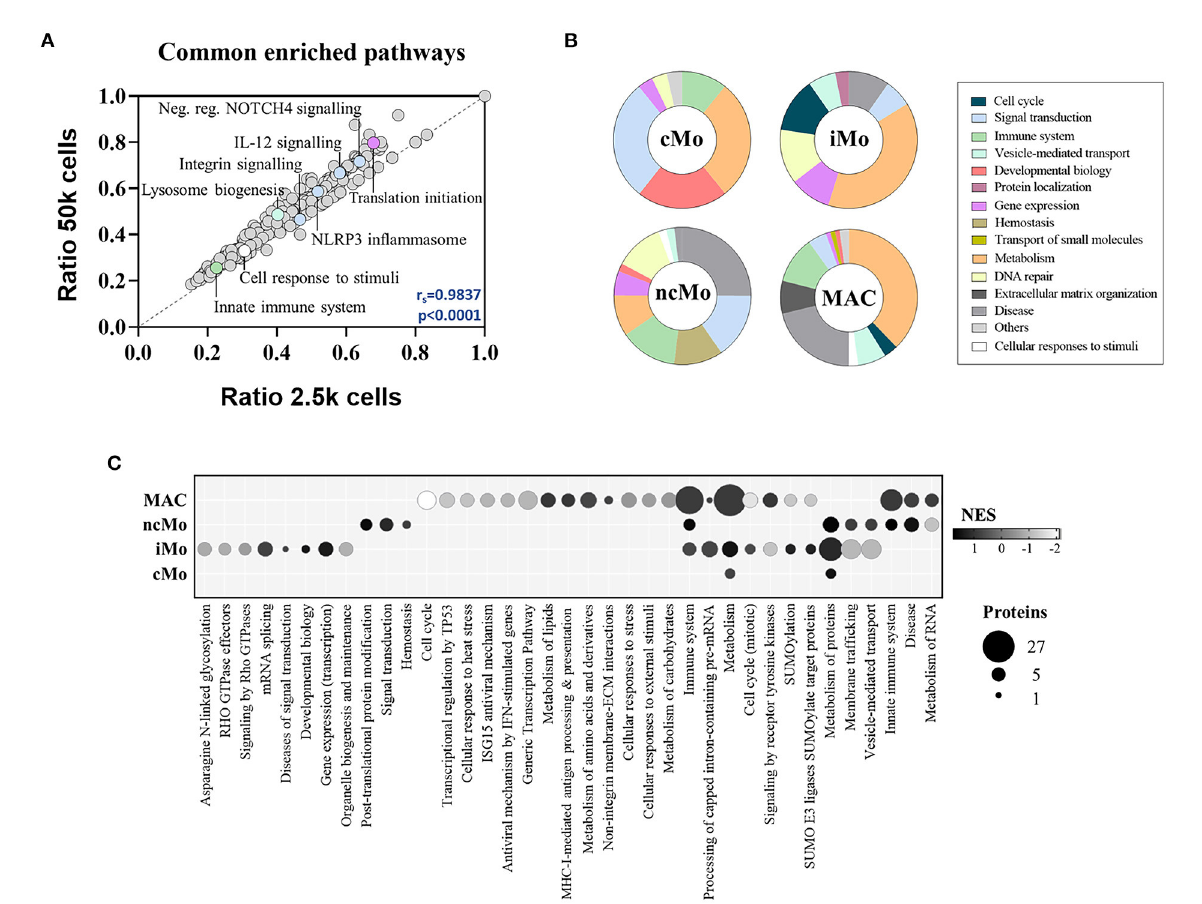
FIGURE5 Functional enrichment analysis of the three major monocytic populations from peripheral blood of healthy donors and macrophages/microglia from glioblastoma patients. (A) Scatter plot showing the correlation between significantly enriched ( p -value < 0.05) functional pathways in 50 and 2.5k cells from all studied populations, based on found entities/total defined ratios calculated from proteins in common for all populations. Spearman correlation coefficient (r s ) and p -value (p) are indicated. (B) Main groups of functional pathways defined by unique proteins per population. (C) Selection of functional pathways determined by distinctive proteins per population. Bubble size is proportional to number of proteins, and bubble color indicates the normalized enrichment score (NES) calculated based on the protein expression data. cMo, classical monocytes; iMo, intermediate monocytes; ncMo, non-classical monocytes; MAC ,